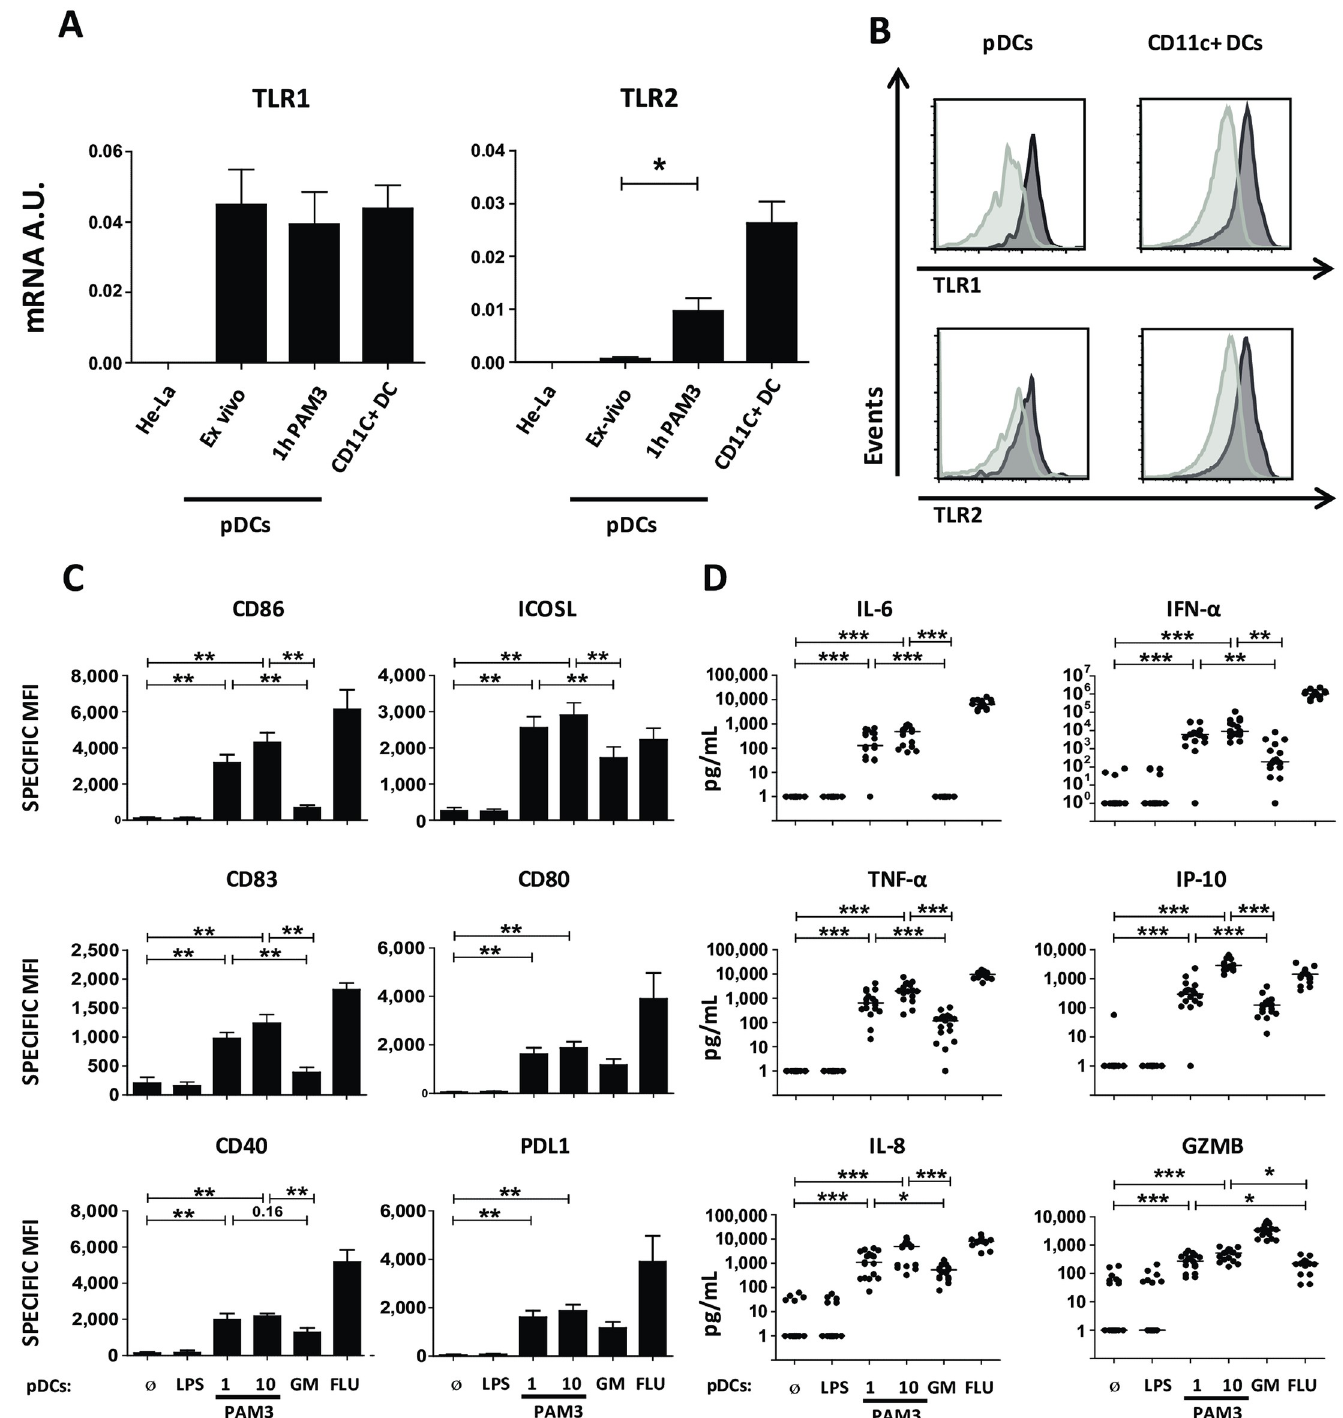
Fig 1. Human pDCs express TLR1/2 and respond to PAM3. (A) RT-PCR quantification of TLR1 and TLR2 expression from total mRNA of sorted human blood pDCs before and after 1-hour activation with PAM3 as compared to CD11c + DCs and HeLa cells. Results were normalized on 3 housekeeping genes. Results include 5 donors. (B) pDCs and CD11c + DCs were stained in freshly isolated PBMCs with anti-TLR1 and anti-TLR2 antibody (dark gray), respective cognate isotype (light gray). (C–D) Sorted human pDCs were cultured during 24 hours with medium ( Ø ), 0.1 μ g/mL LPS, 1 and 10 μ g/mL PAM3, 100 ng/mL GM, or 82 HA/ml FLU. (C) Specific MFI for surface expression of costimulatory or coinhibitory molecules from activated pDCs by FACS. Results include the mean of 9 donors. (D) Cytokine secretion by pDCs. Results include the mean of 17 donors. Each dot represents a donor. � p < 0.05; �� p < 0.01; ��� p < 0.001 (Wilcoxon test). Underlying data for this